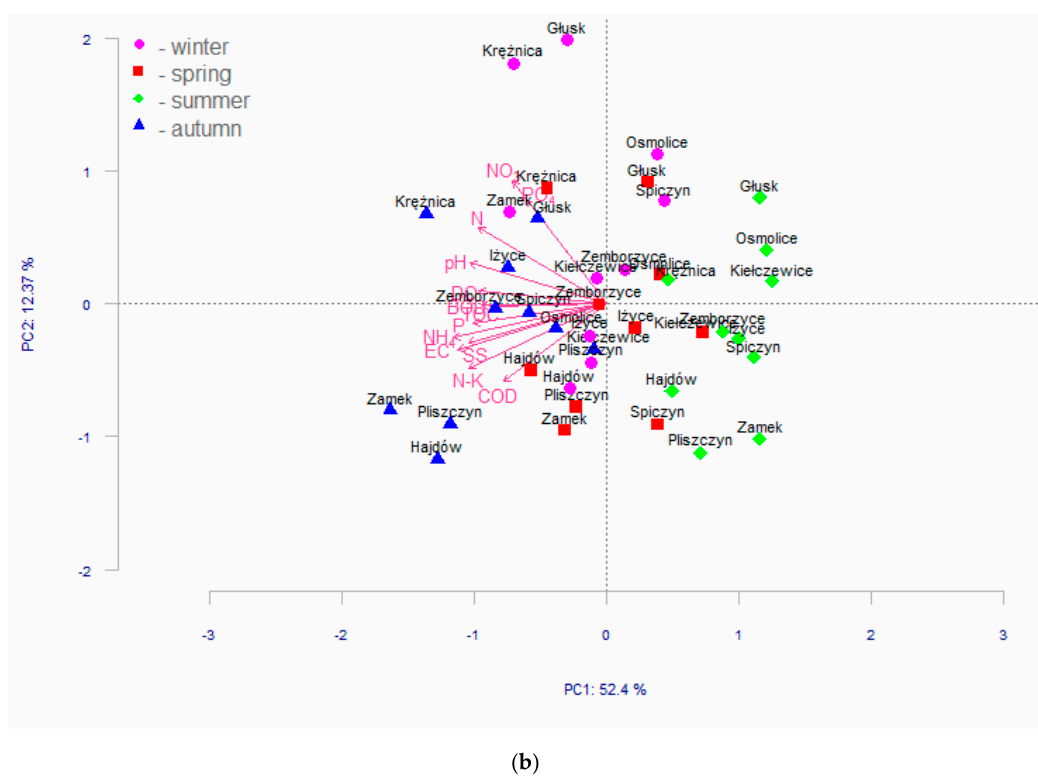
Figure 3. Results of the principal component analysis for: ( a ) measuring stations, ( b ) seasons.